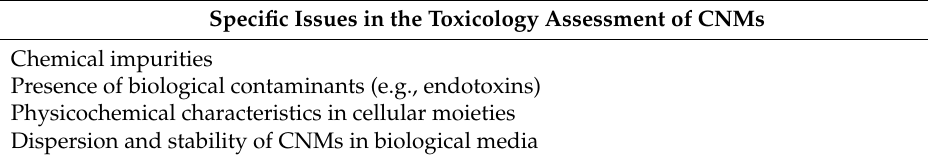
Table 4. Issues to consider when addressing the toxicity assessment of